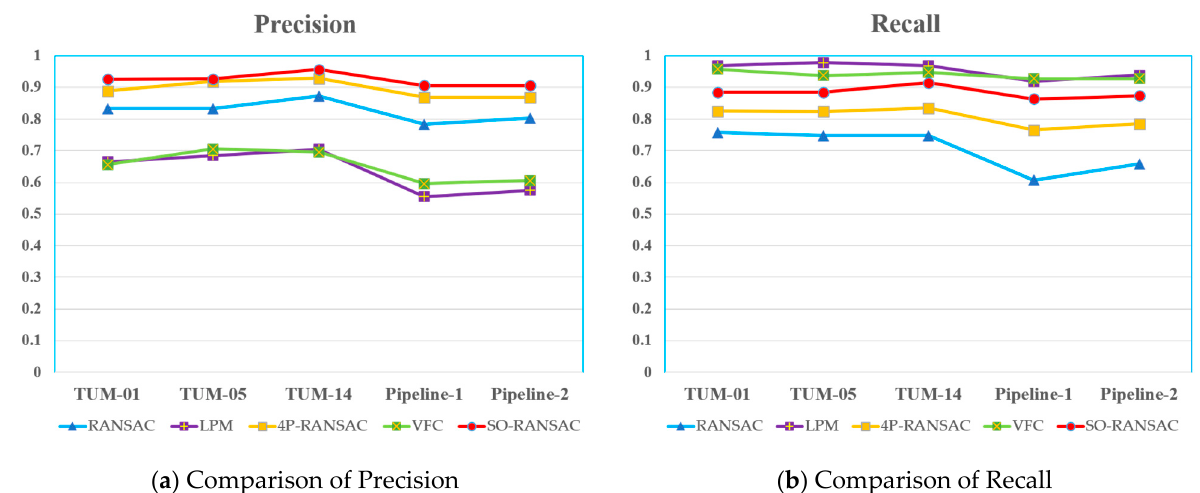
Figure 8. Precision and recall of each method in the five sets of experimental data: ( a ) precision and ( b ) recall.